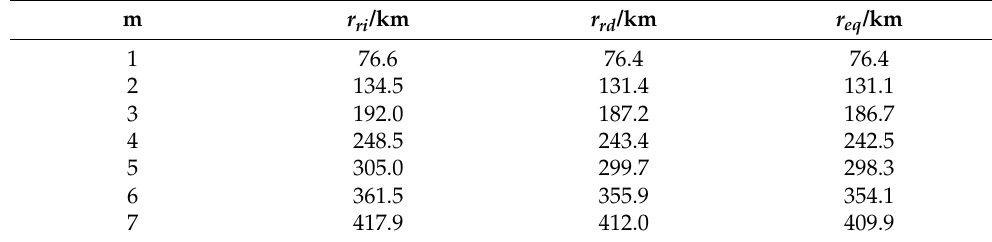
Table 2. Positions of convergence zones obtained using proposed formulation and coupled normal mode.